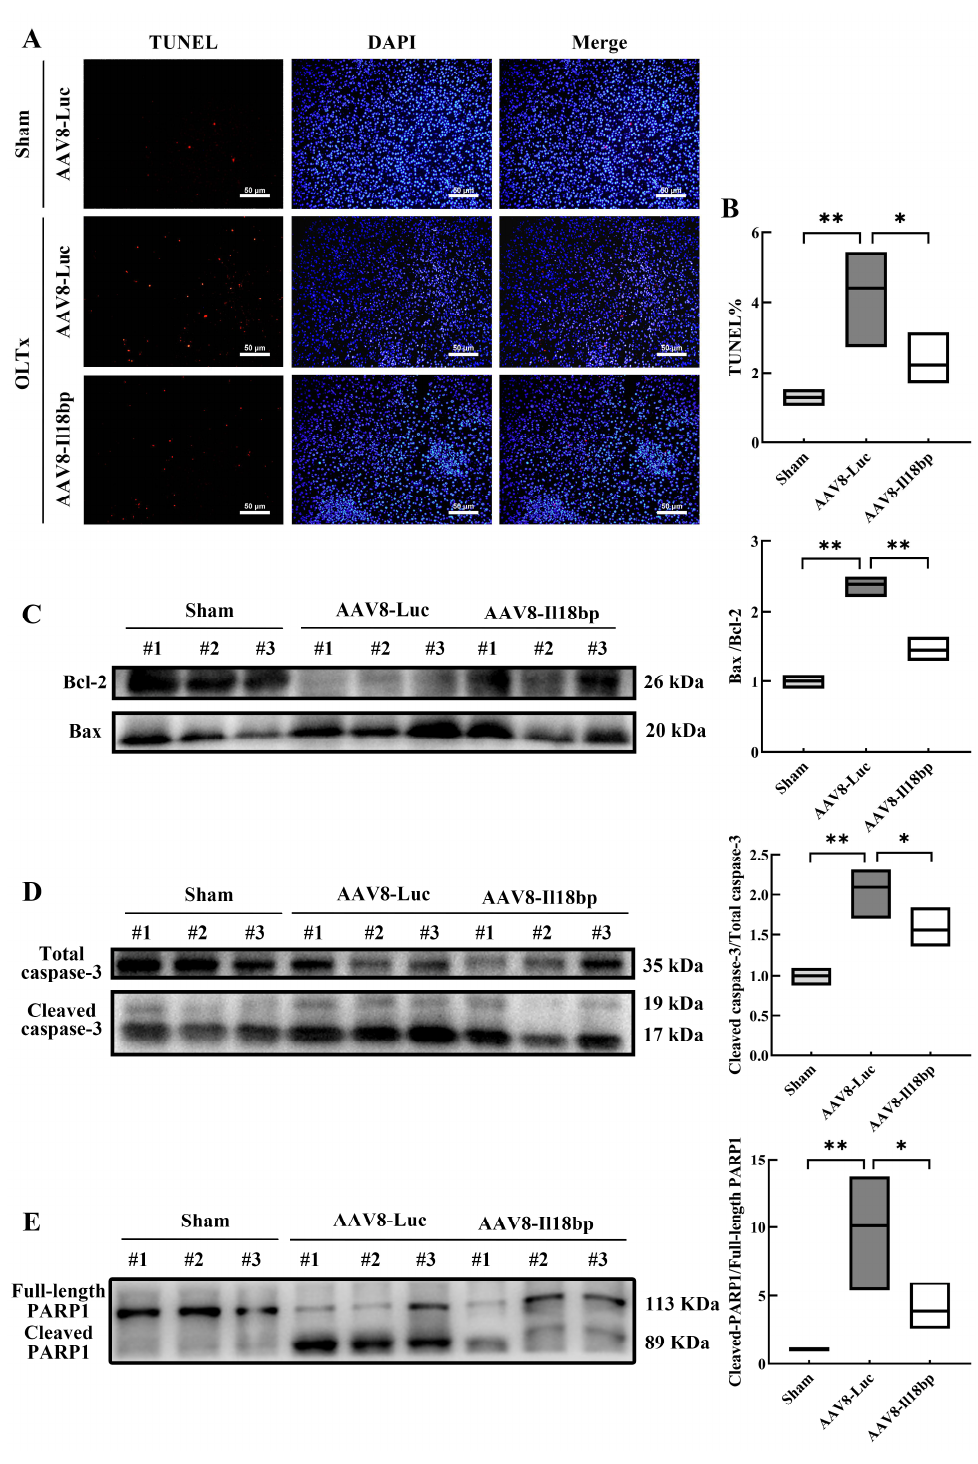
Figure 5. Elevated IL-18BP levels protected the liver from apoptosis after LEW-BN OLTx. ( A ) TUNEL staining was performed to assess the apoptosis rate. Representative photomicrograph of TUNEL-positive staining (red) in the liver in different groups (scale bar = 50 μm). ( B ) Ratios of TUNEL-positive cells in the liver in different groups. ( C ) Bax and Bcl-2 protein expression in different groups were analyzed by Western blotting. ( D ) Total caspase-3 and cleaved caspase-3 protein expression in different groups were analyzed by Western blotting. ( E ) Full-length PARP1 and cleaved PARP1 protein expression in different groups were analyzed by Western blotting. TUNEL: terminal deoxynucleotidyl transferase biotin-dUTP nick end labeling. Results represent the mean ± SEM ( n = 3 per group); * p < 0.05; ** p <